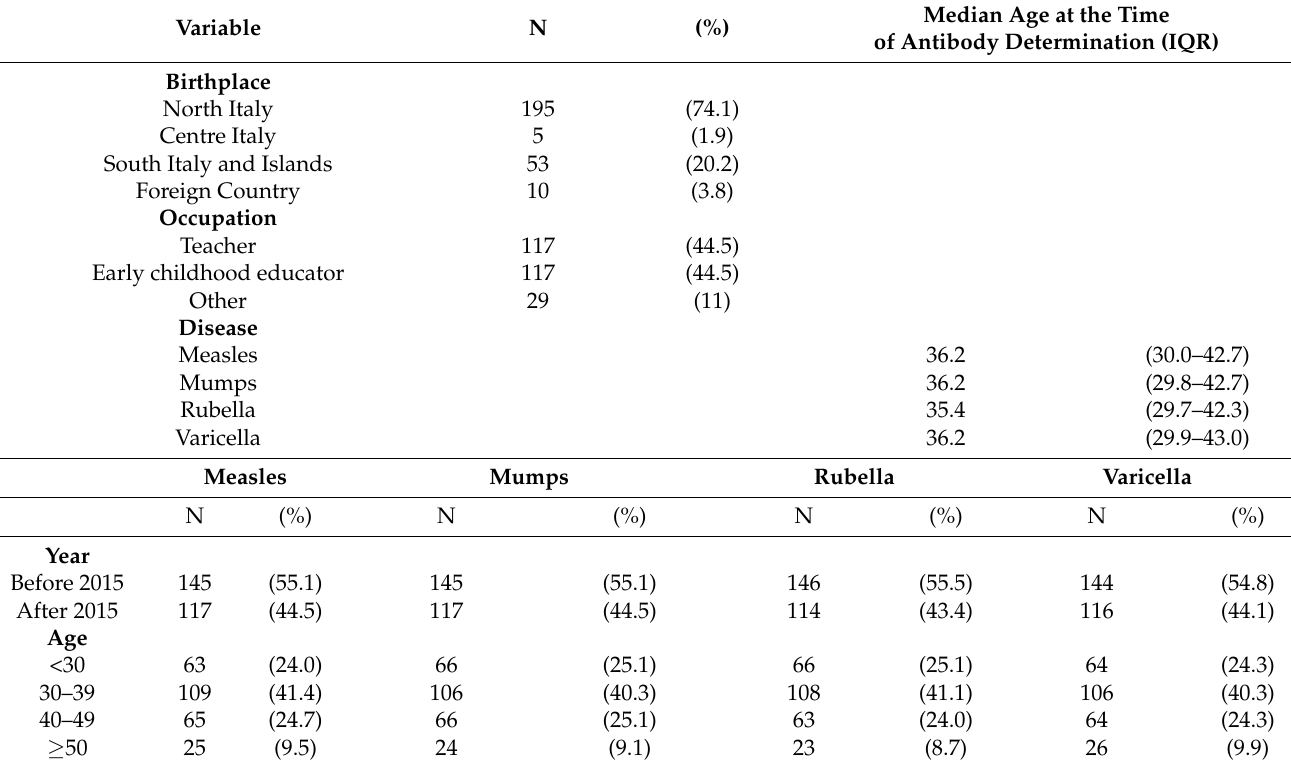
Table 1. Characteristics of the study population (N = 263 female school workers), Italy.